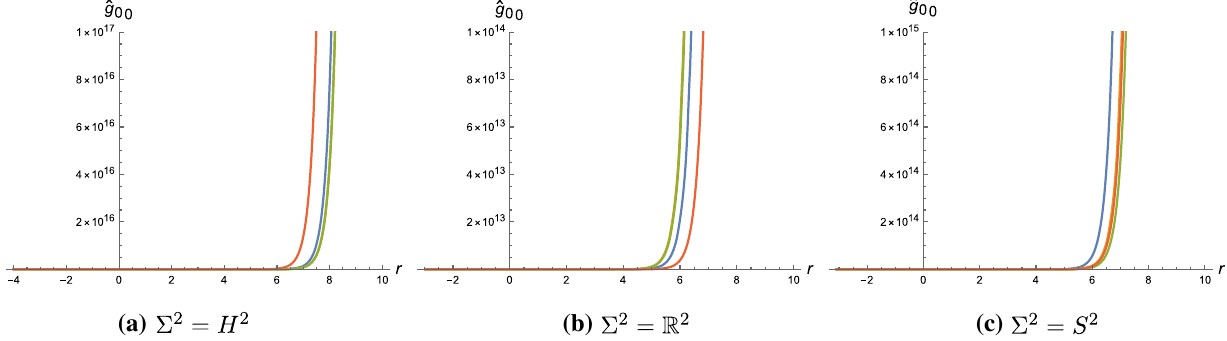
Fig. 4 The behavior of ˆ g 00 along the RG flows from the N = 4 AdS 7 critical point as r → ∞ to AdS 5 × (cid:2) 2 fixed points and curved domain walls with SO ( 2 ) × SO ( 2 ) symmetry for (cid:2) 2 = H 2 , R 2 , S 2 in SO ( 5 ) gauge